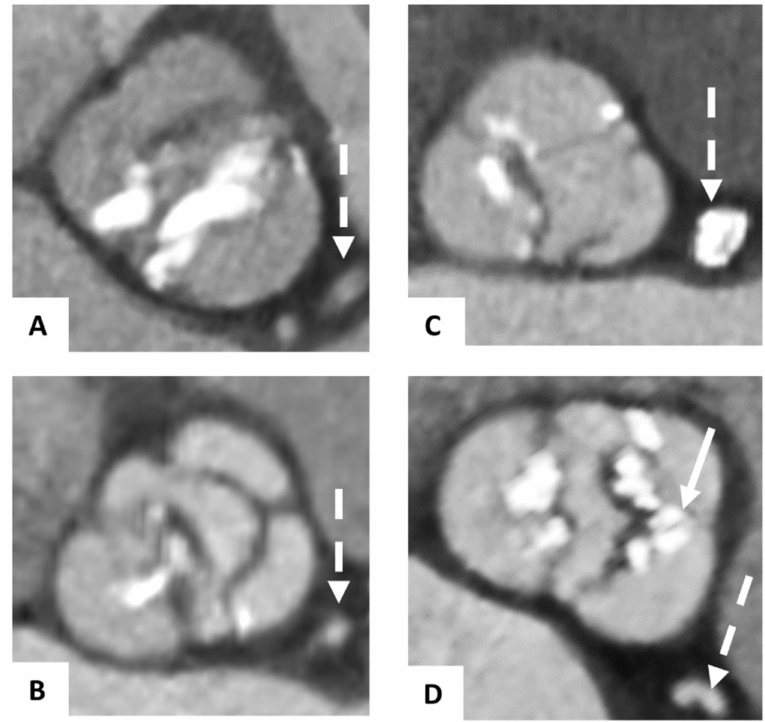
Figure 1. Classification of bicuspid aortic valves. Pre-TAVI contrast-enhanced CTA axial showing congenital bicuspid aortic valves classified according to the schema of Sievers and Schmidke with Type 0 ( A ), Type 1 L/R (with raphe between the left and right coronary cusps) ( B ), Type 1 R/N (with raphe between the right and non-coronary cusps), ( C ) and a functional bicuspid aortic valve ( D ) with secondarily fused left and right coronary cusps due to severe calcification ( → ). The dashed arrow (--->) is marking the left coronary artery